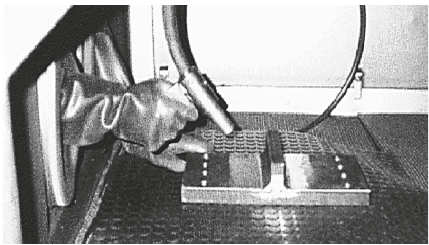
Figure 3: T-butt welded specimen during shot peening process (blast